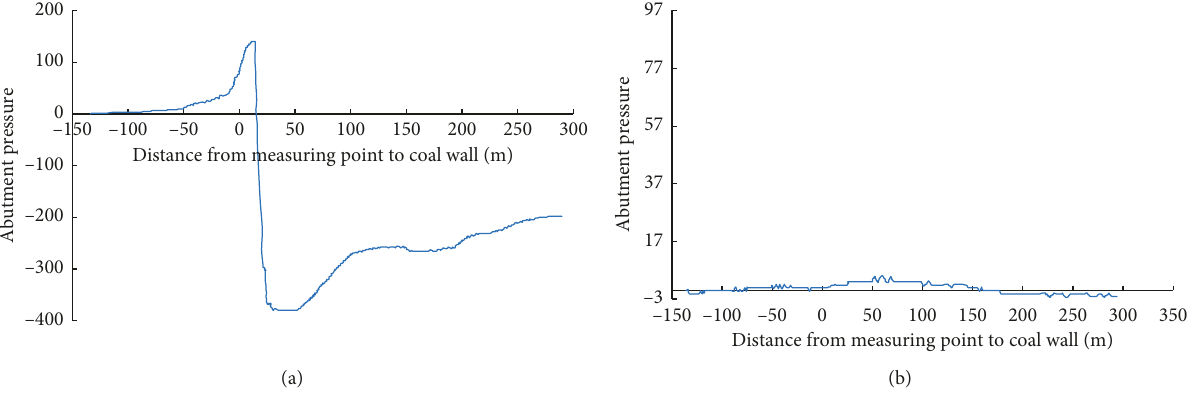
Figure 14: The changing curve of the abutment pressure in the roof as the advancement of working face at the floor strata 150 m away from the open cut (in the downhill mining section). (a) Roof (located at pressure cell 15). (b) Floor (located at pressure cell 5).